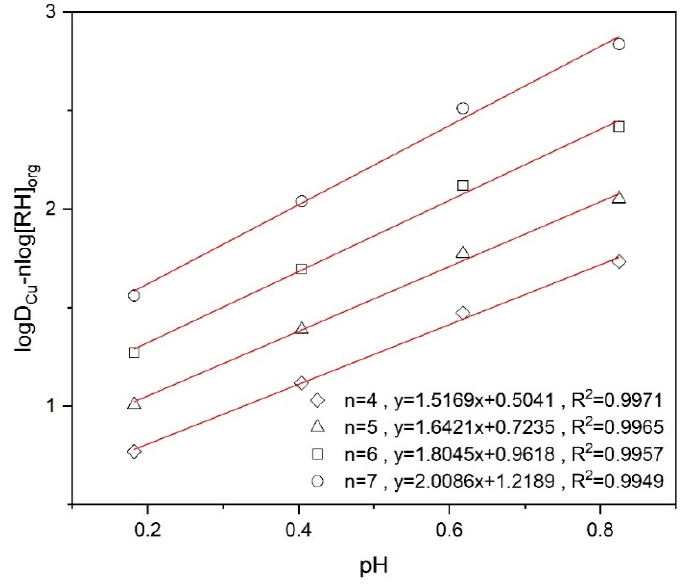
Figure 9. logD Cu –nlog[RH] org versus pH at different n values using 10% ( v / v ) Mextral5640H.